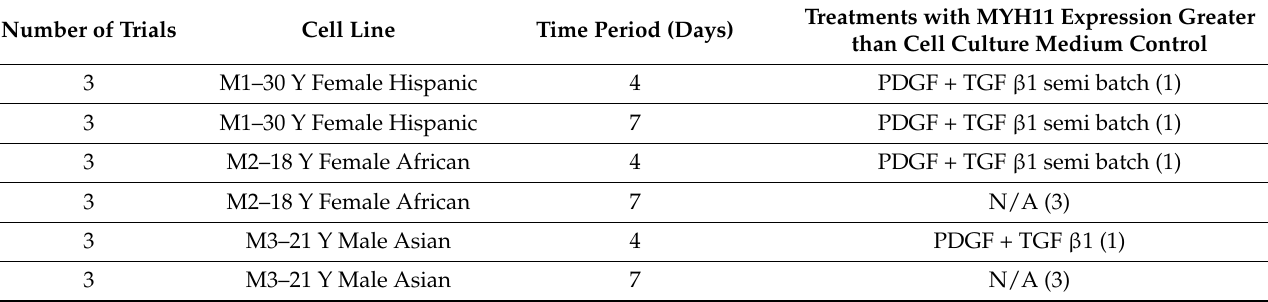
Table 1. Application of three different growth factor-based DM treatments for a time point of four and seven days on three different bone marrow-derived stem cell lines. N/A in column 4 refers to results where none of the cell line samples in DM medium could show a higher expression of MYH11 than cell lines grown in CCM. Only PT (semi-batch) and PT treatment could elicit MYH II expression greater than CCM control in at least one trial.